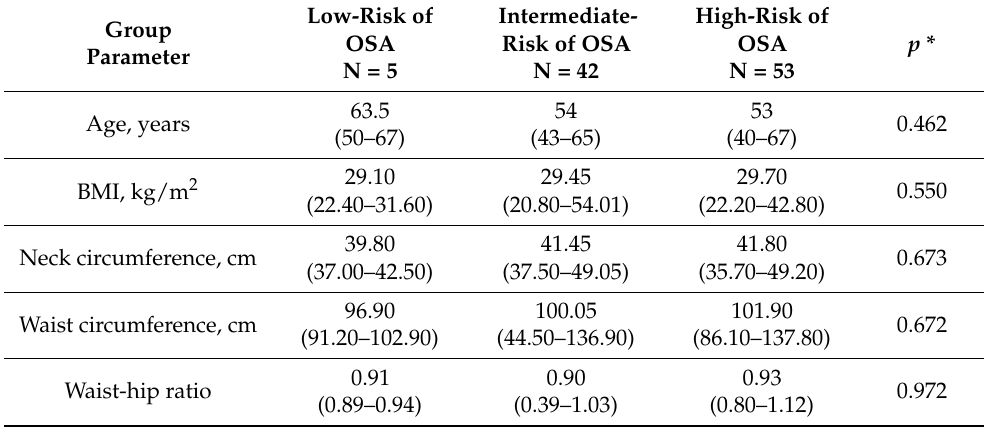
Table 1. Medians (min-max) of anthropometric measurements for all participants divided into three group according to estimated risk of OSA through STOP-Bang